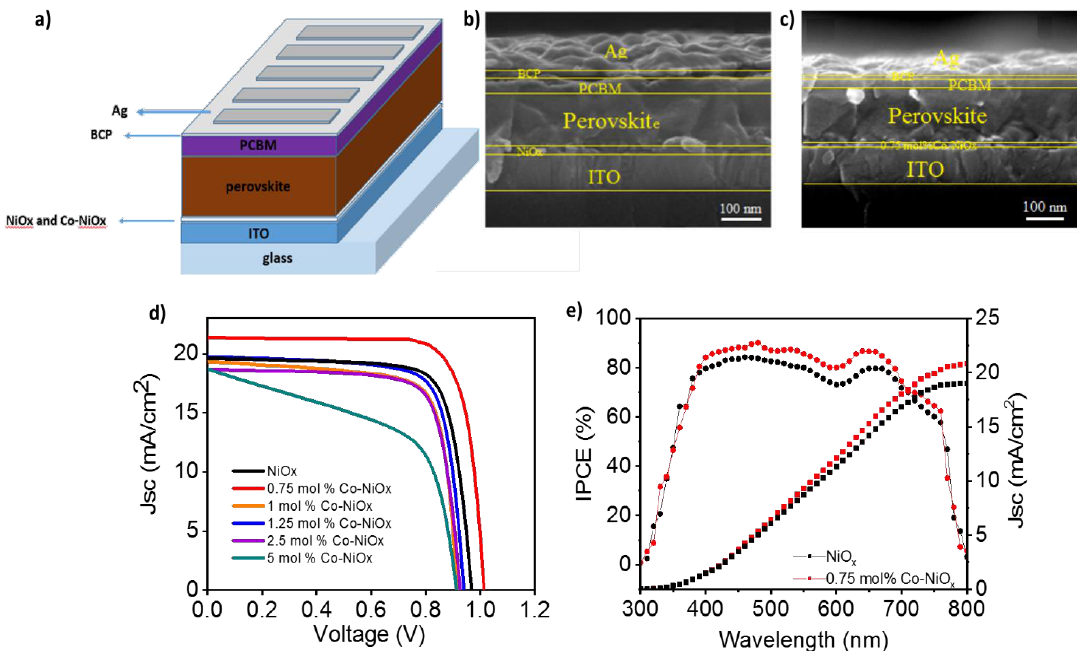
Figure 6. ( a ) Sketch of the device architecture; Cross-sectional SEM images for perovskite layers fabricated on the top of NiO x or Co-NiO x layer: ( b ) NiO x and ( c ) 0.75 mol% Co-NiO x ; ( d ) J / V curves of PSCs using 0.75–5 mol% Co-NiO x and bare NiO x as hole-transporter materials (HTMs). ( e ) incident photons to current efficiency (IPCE) of 0.75 mol% Co-NiO x and NiO x based champion base devices. Table 2. Photovoltaic performance by J / V measurements with reverse scan under standard illumination (100 mW cm − 2 ) for champion devices and